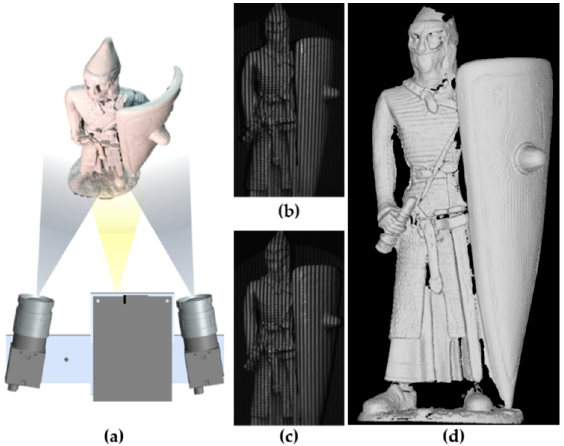
Figure 1. ( a ) Our active stereo vision system configuration; ( b ) Image taken from left camera: structured light is projected onto the target object; ( c ) Image taken from right camera: structured light is projected onto the target object; ( d ) Acquired 3D scan data.